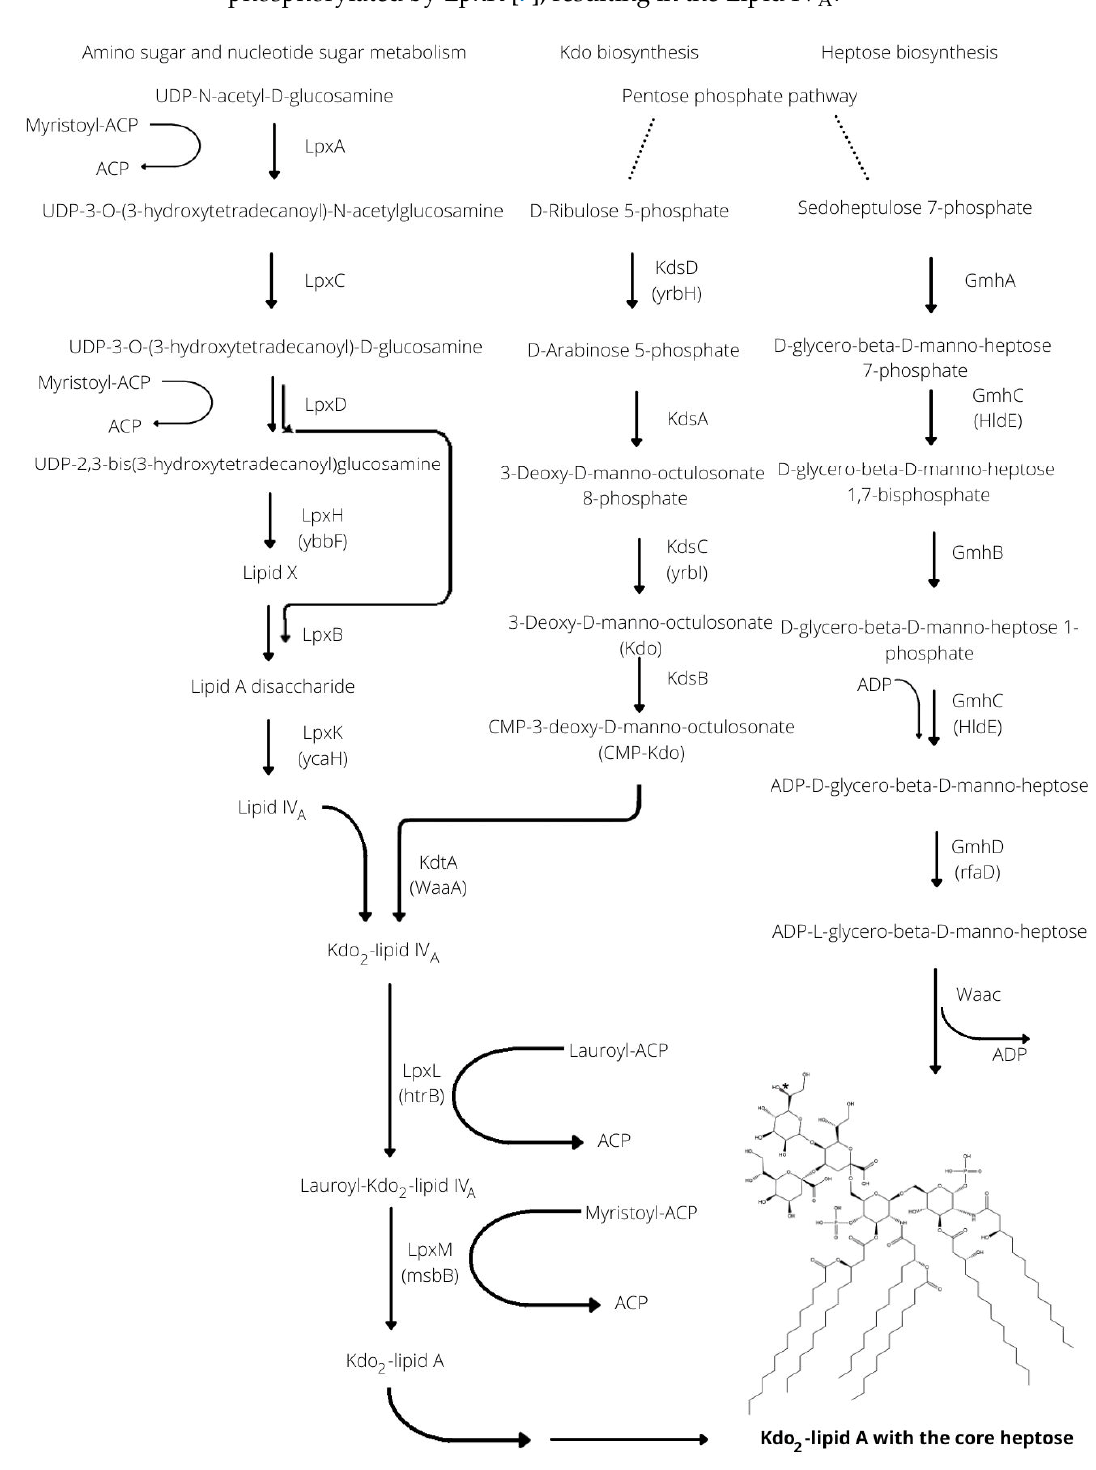
Figure 1. The scheme showing the synthesis steps of the three major constituents—Lipid IV A , Kdo, and ADP-L-glycero- β -D-manno-heptose—of the Rd2-LPS structure. The enzymes involved in the biosynthetic steps are indicated at the arrows. The star (*) is labeling the D configuration of the OH-group in the heptose structure.